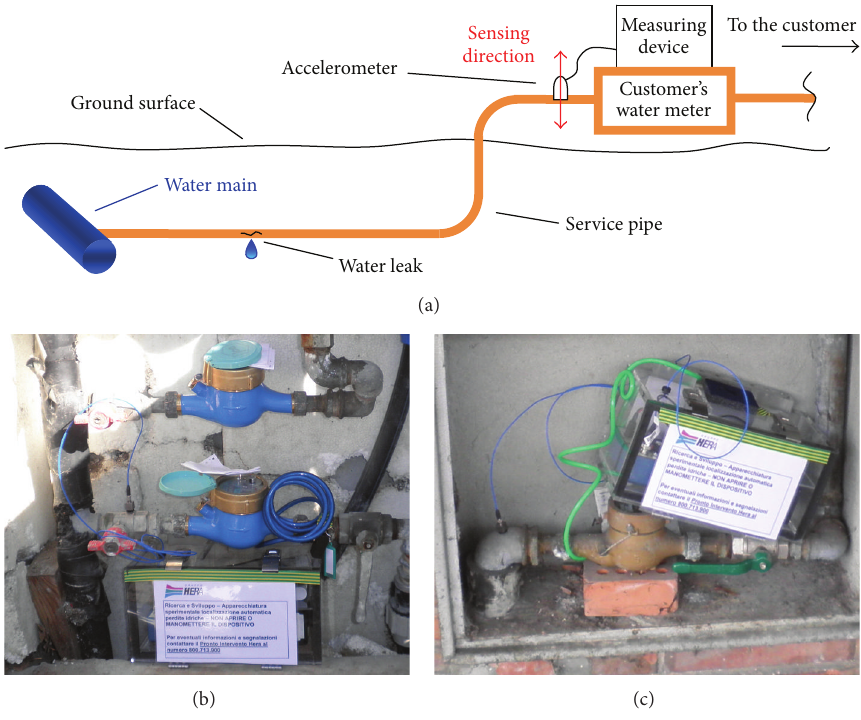
Figure 2: Pictures of the measurement setup for two monitored